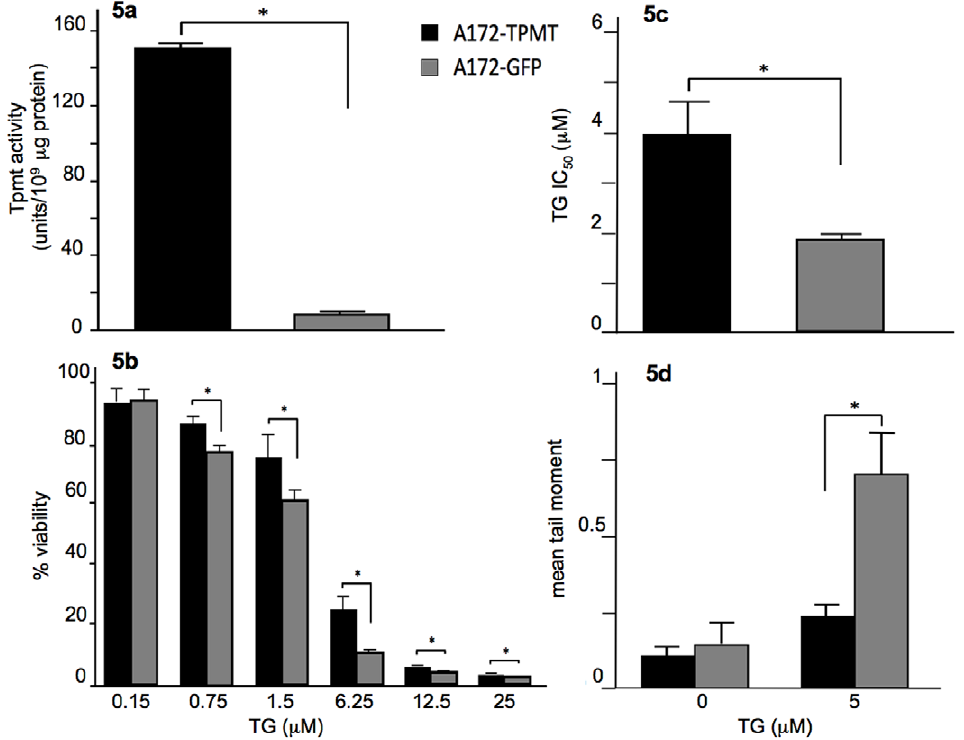
Figure 5. Comparison of Tpmt-associated phenotypes in A172 isogenic cells. Tpmt protein activity was measured in A172 mock and A172 Tpmt cell lines. (a) Tpmt protein activity was significantly higher in A172 Tpmt (p , 0.05); additionally, (b) A172 Tpmt showed a significantly higher resistance to TG-induced toxicity when compared to A172 mock as determined by the MTT cell viability data (p , 0.005) and (c) by IC 50 values (p , 0.05). (d) The alkaline comet assay was used to compare TG-induced DNA damage. A172 mock displayed a significantly higher DNA damage than A172 Tpmt (p=0.03) as measured by mean comet tail moment. Bars represent the means; whiskers represent the standard deviation ( 6 ). * p , 0.05.